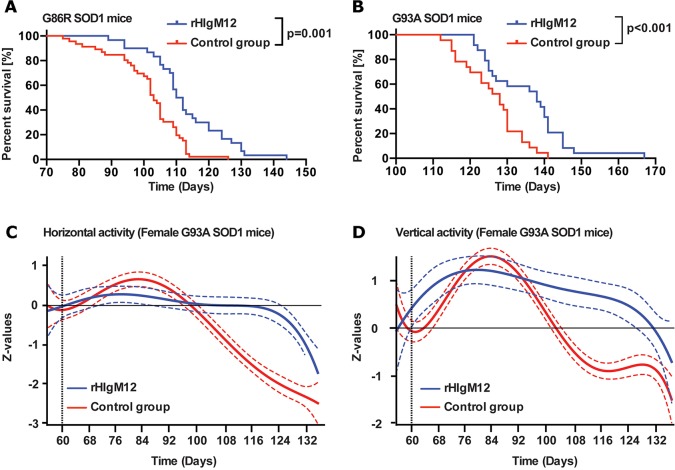
rHIgM12 enhances survival of SOD1 mice and slows deficit progression. (A,B) A single 200 μg intraperitoneal dose of rHIgM12 given at 8 weeks of age increased survival of both the SOD1G86R (rHIgM12 n=30 females, control n=35 females) and SOD1G93A (rHIgM12 n=24, control IgM n=23) strains of mice. Lifespan was plotted using Kaplan–Meier curves and analyzed using GraphPad Prism (P<0.0001, Log-Rank test). (C,D) A subset of female SOD1G93A mice at 56 days of age were placed as groups of five in AccuScan locomotor activity-monitoring boxes and monitored continuously. Baseline activity (beam breaks/hour) collected over 4 days is represented as the horizontal line at 0. Mice were treated with a single dose of 200 μg of rHIgM12 or PBS at 60 days of age. Nocturnal horizontal activity (C) and vertical activity (D) are graphed using a fifth-order polynomial fitting of standardized z-values. rHIgM12 treatment distinctly preserved spontaneous movement (C) and rearing (D). The point-wise 95% confidence bands for the polynomial curves are indicated by hashed lines surrounding the red and blue lines and indicate the times of significant differences between groups. Horizontal axis indicates age of mice in days.